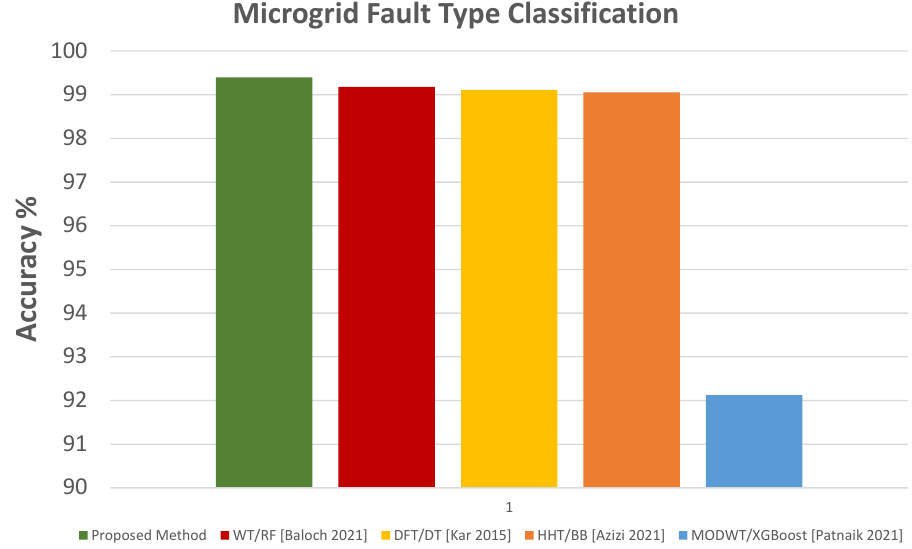
Figure 25. Accuracy comparison with other FTC methods